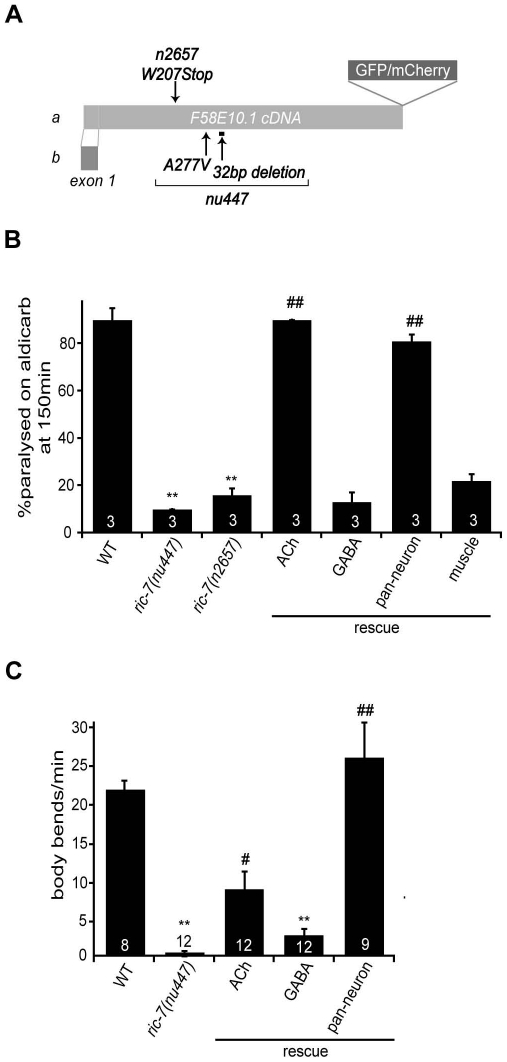
Aldicarb response and locomotion defects in ric-7 mutants.(A) A schematic illustrating the ric-7 gene structure is shown. Deleted regions (bar), point mutations (arrows), and the site utilized for GFP/mCherry tagging are indicated. (B–C) Aldicarb-induced paralysis (B) and locomotion rate (C) are compared for the indicated genotypes. The number of trials (∼20 animals/trial, B) or the number of animals analyzed (C) are indicated for each genotype. For rescue experiments, ric-7 transgenes are indicated as follows: ACh (unc-17 promoter), GABA (unc-25 promoter), pan-neuron (snb-1 promoter), muscle (myo-3 promoter). Values that differ significantly from wild type (**, p<0.001, Student's t-test) and from ric-7 mutants (#, p<0.01; ##, p<0.001, Student's t-test) are indicated. Error bars indicate SEM.